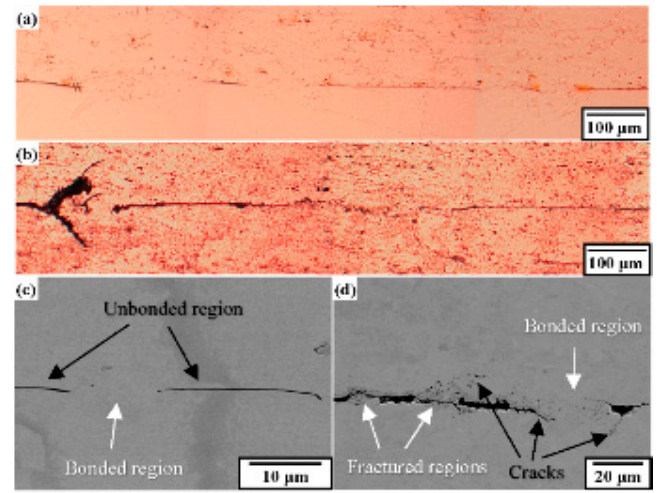
Figure 5. Cross-sectional images of the heel region in C1020 joints before ( a , c ) and after ( b , d ) thermal cycling test. ( a , b ) optical microscope (OM) images of the joint. ( c , d ) SEM images of the bonded region.